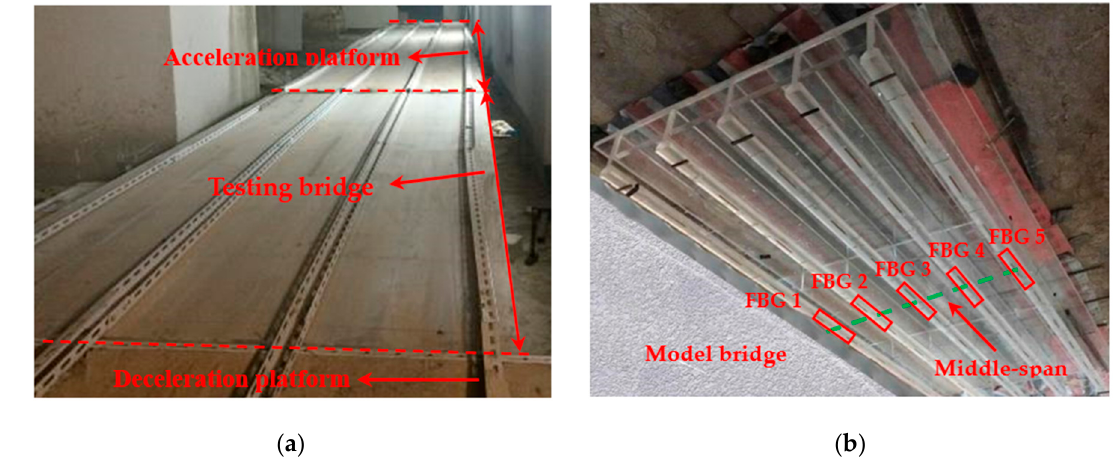
Figure 12. ( a ) Experimental platform, ( b ) model bridge.